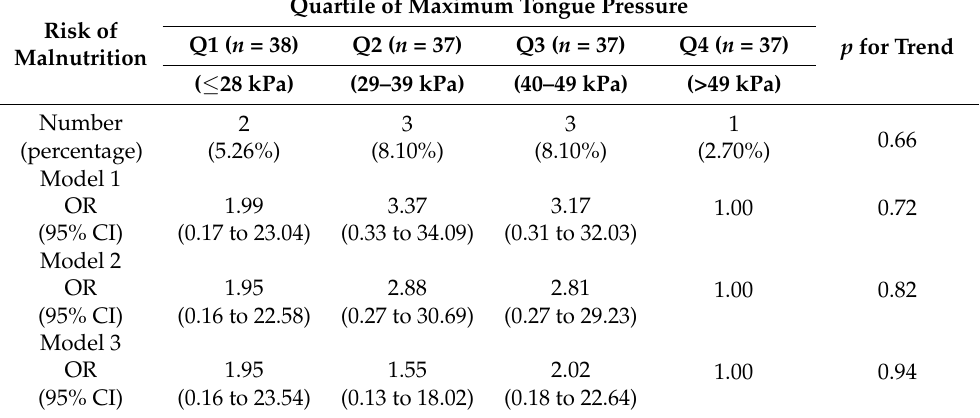
Table 4. The association of risk of malnutrition with different quartiles of tongue pressure in the male participants. Risk